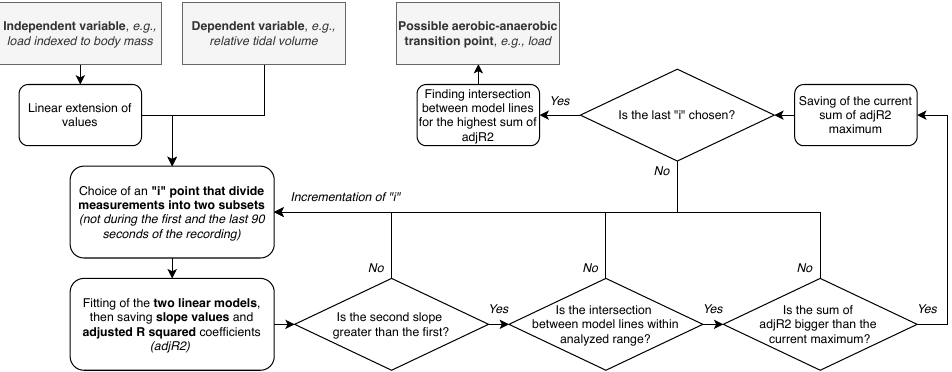
Figure 2. The idea of how the transition point suggesting gas exchange threshold can be